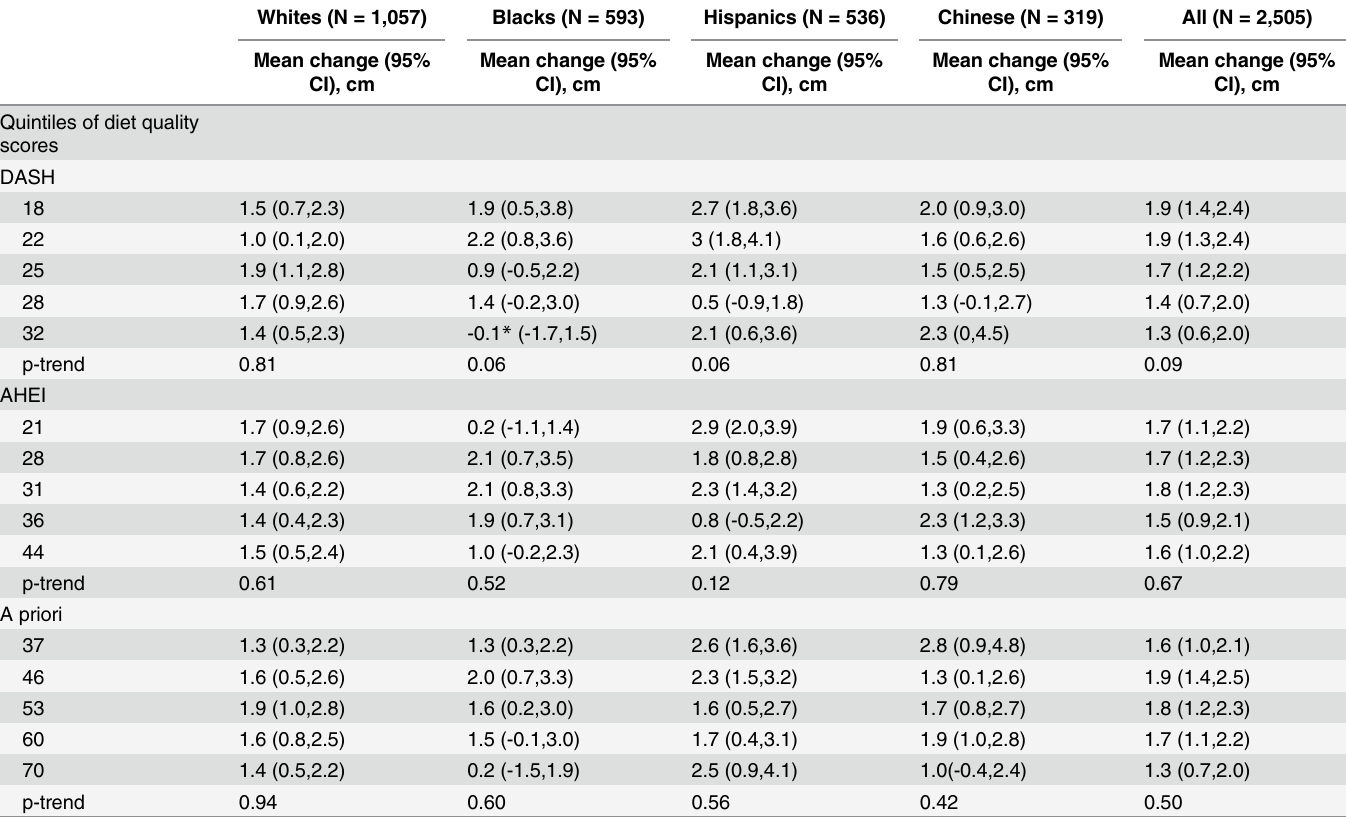
Table 2. Multivariate-Adjusted 5-year Change in Waist Circumference according to Quintiles of Diet Quality Scores by race-ethnicity in 2,505 US adults. Whites (N =